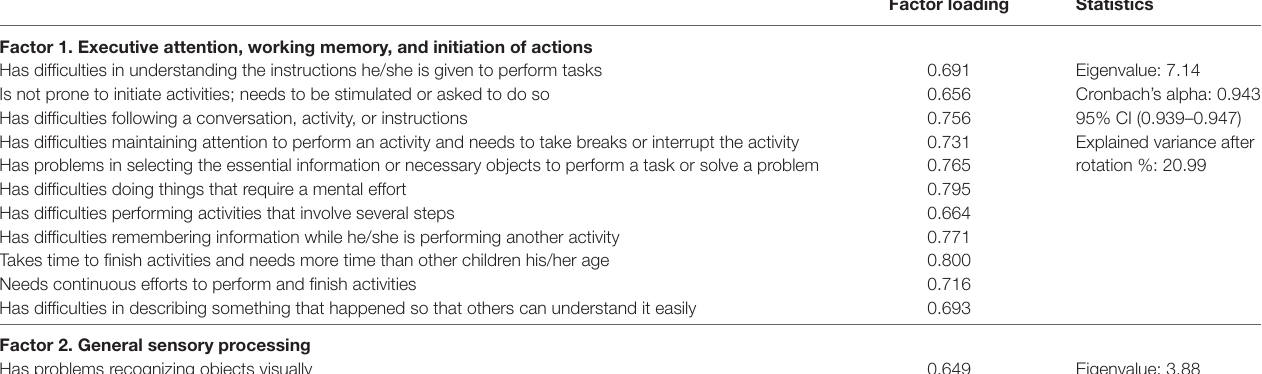
tAble 2 | Results of the factor analysis.